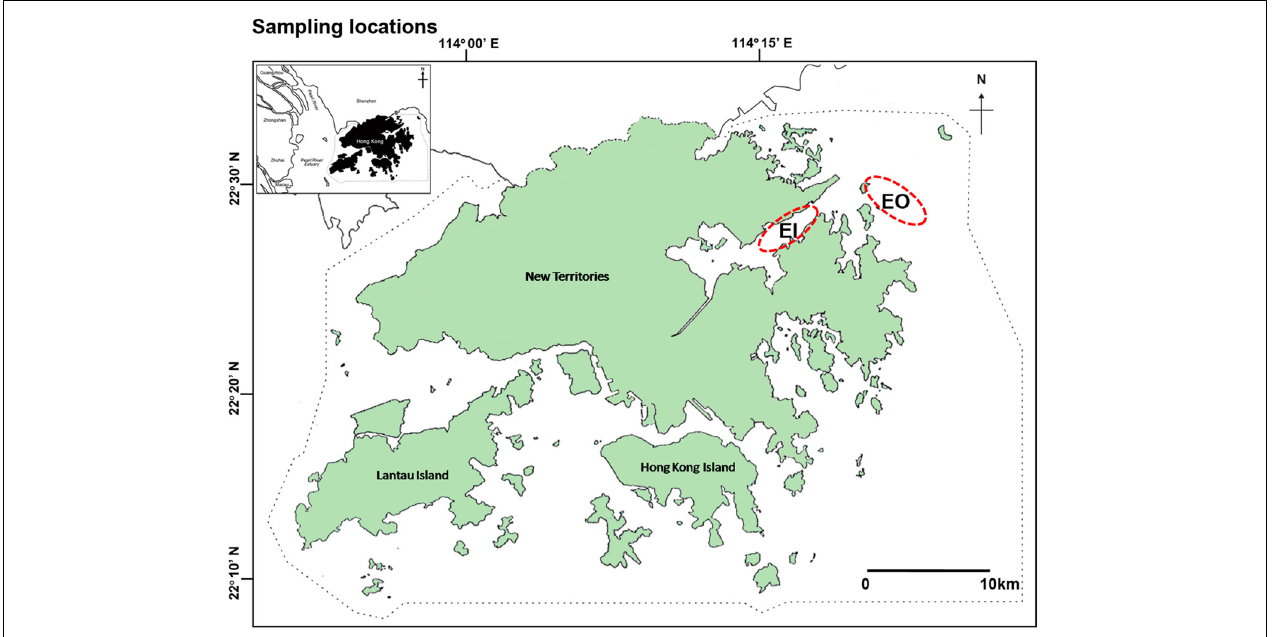
FIGURE 1 | Sampling locations of benthic crustaceans in Hong Kong waters: inner Tolo Channel (EI) and outer Tolo (EO). Dotted line is Hong Kong jurisdictional boundary inside which all trawling-based fishing activities are